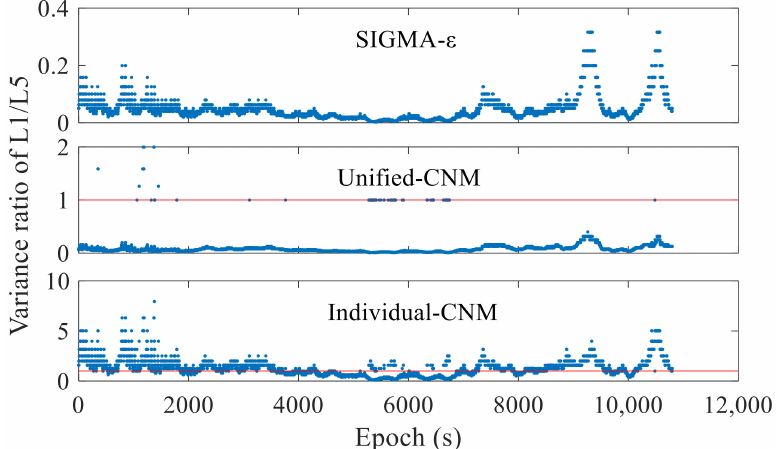
Figure 6. Variance ratio of bands G26 L1 and L5 for C/N0 stochastic models.